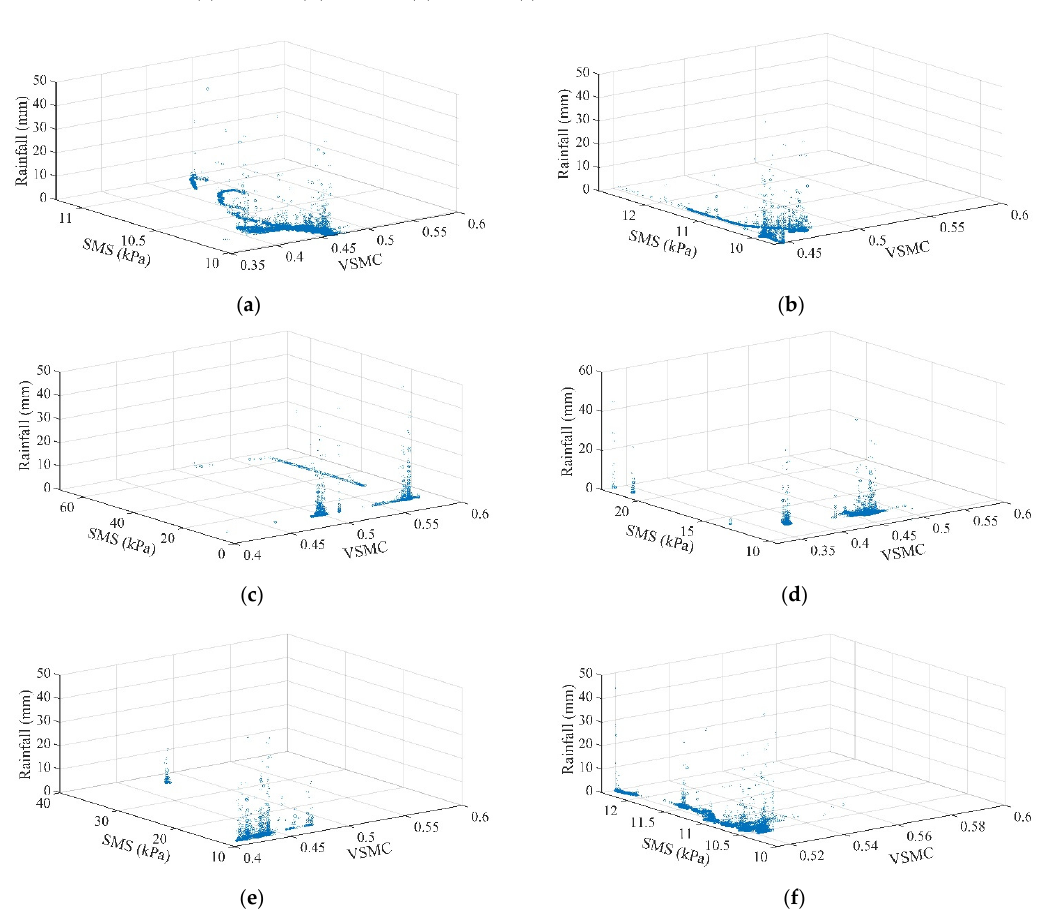
Figure A2. 3D in situ variation of rainfall SMS and SMS at 4.5 m depth ( a ) HWS 1 ( b ) HWS 2 ( c ) HWS 3 ( d ) HWS 4 ( e ) HWS 5 ( f ) HWS 6. y = 0.4473x - 0.0614 R² = 0.2905